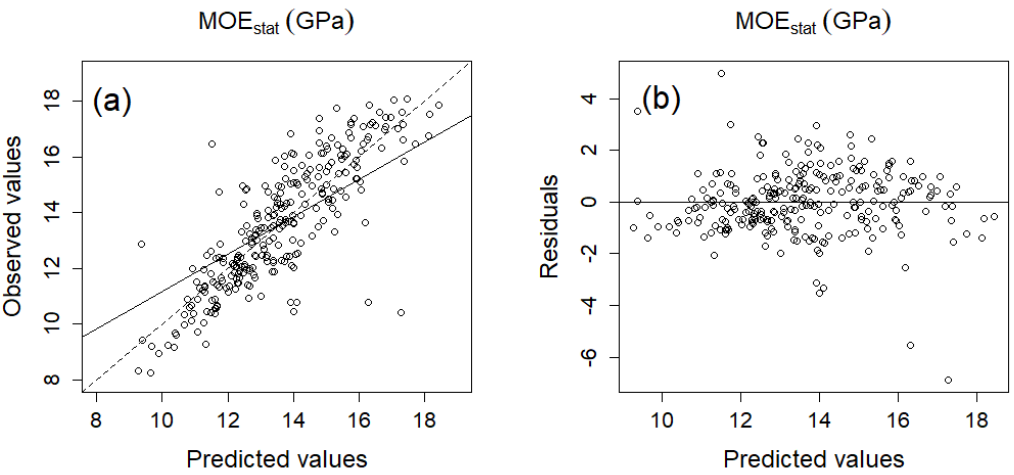
Figure 3. ( a ) Observed vs. predicted boards Static Modulus of Elasticity (GPa) for the entire dataset, ( b ) residuals ( n boards = 268). Solid line represents the regression line. Table 7. Classification of boards via the equation developed through AWV and relative error. Predicted % Grade AWV Grade